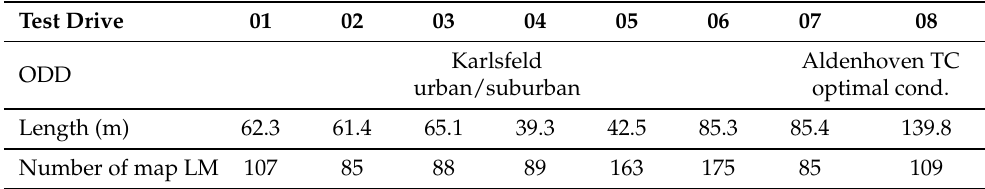
Table 2. Overview of the selected drives: ODD definitions, length, and number of existing landmarks based on pre-built HD maps of the respective